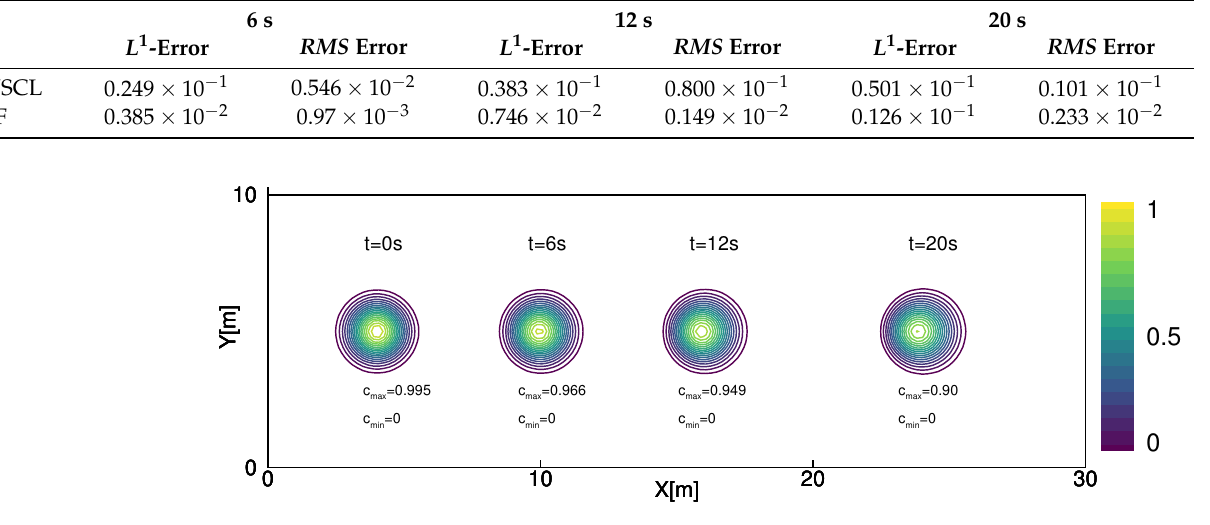
Figure 4. Pollutant concentration distribution in the channel at times t = 0 s, 6 s, 12 s, and 20